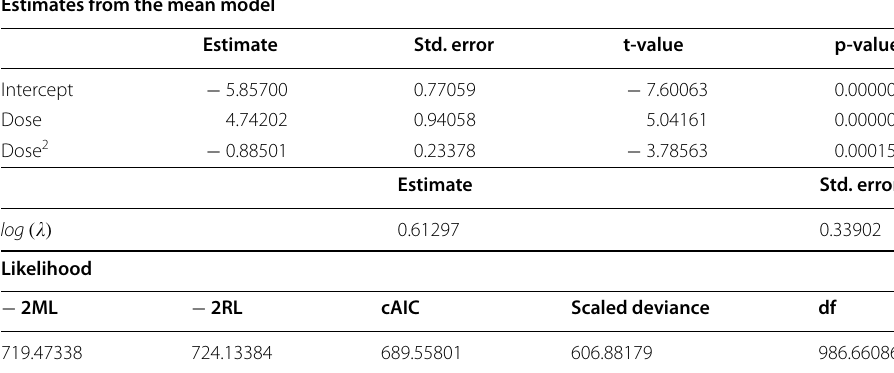
Table 5 Results for weight model Estimates from the mean